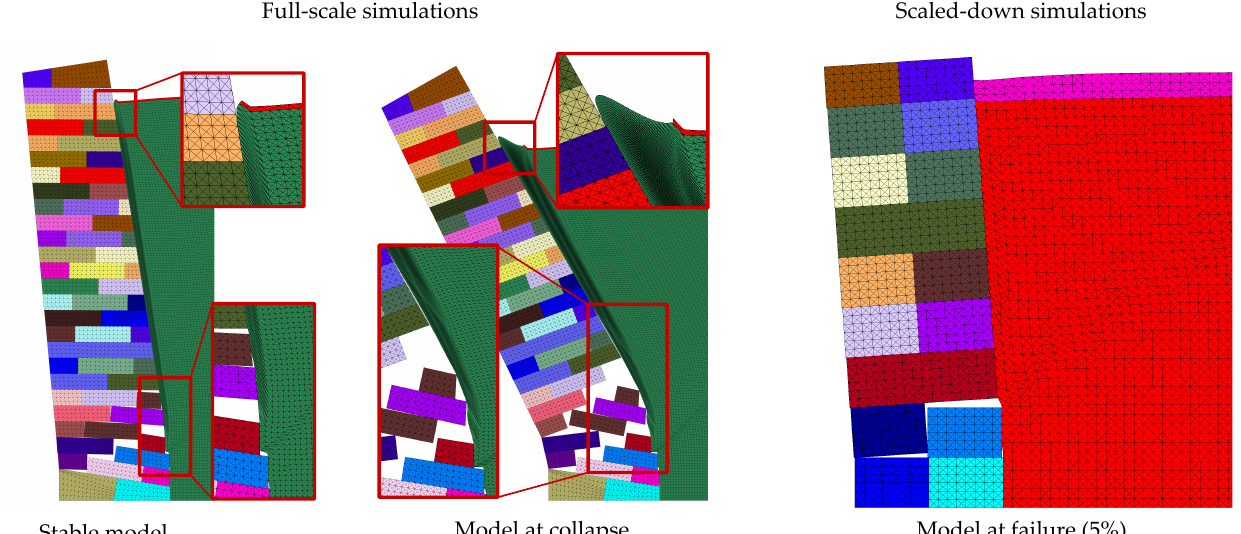
Figure 11. Numerically obtained deformation for DSRW1. At the wall’s collapse, the backfill is still in contact with the wall and adapts well to the sliding between courses. Similar findings are obtained when modelling the experiments (Section